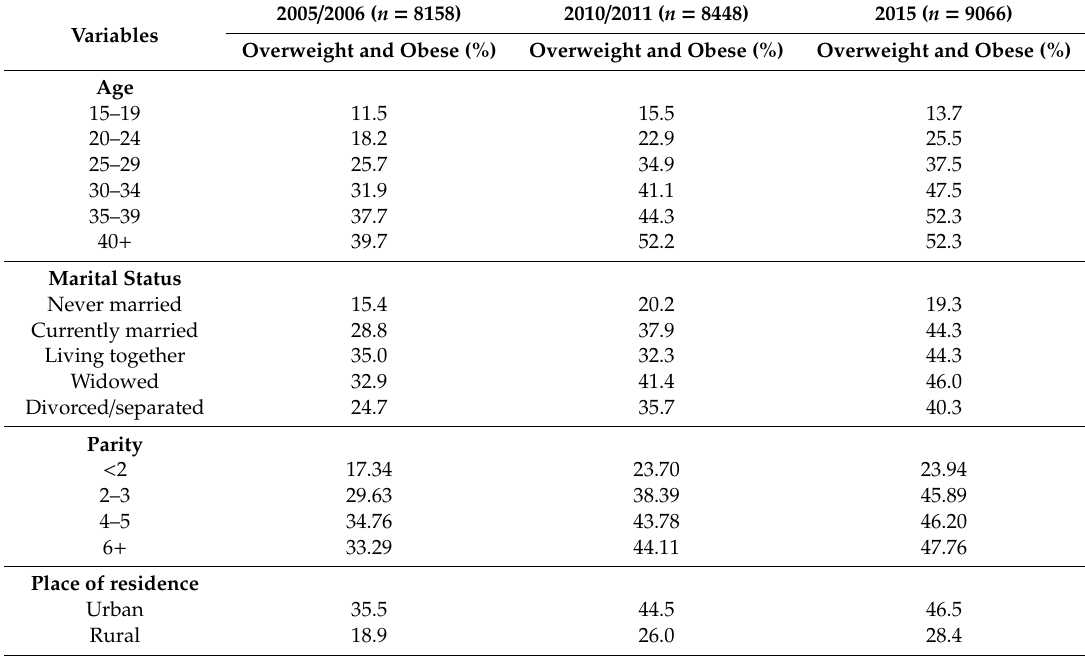
Table 2. Prevalence of overweight and obesity by demographic, socioeconomic and behavioral risk factors among women of reproductive age (15–49 years) in Zimbabwe,